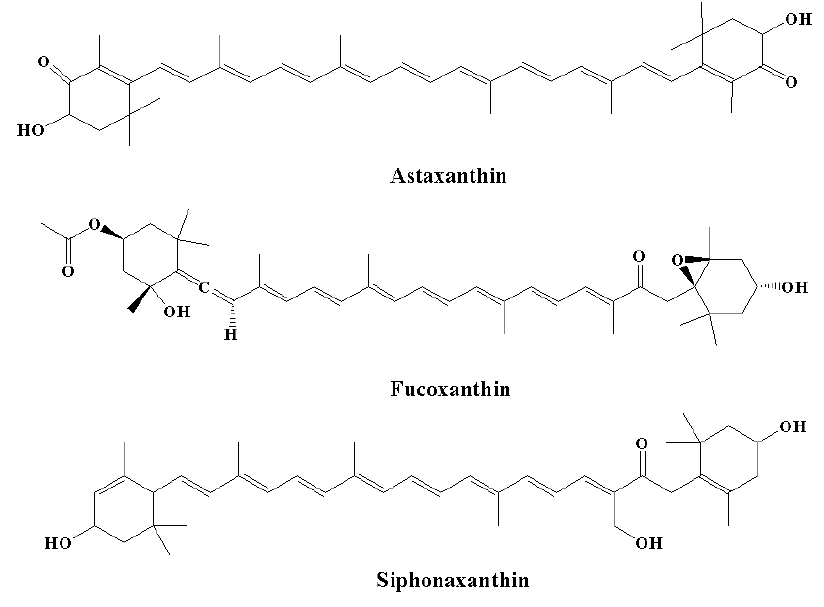
Figure 6. Chemical structures of natural marine pigments with anti-inflammatory potential.